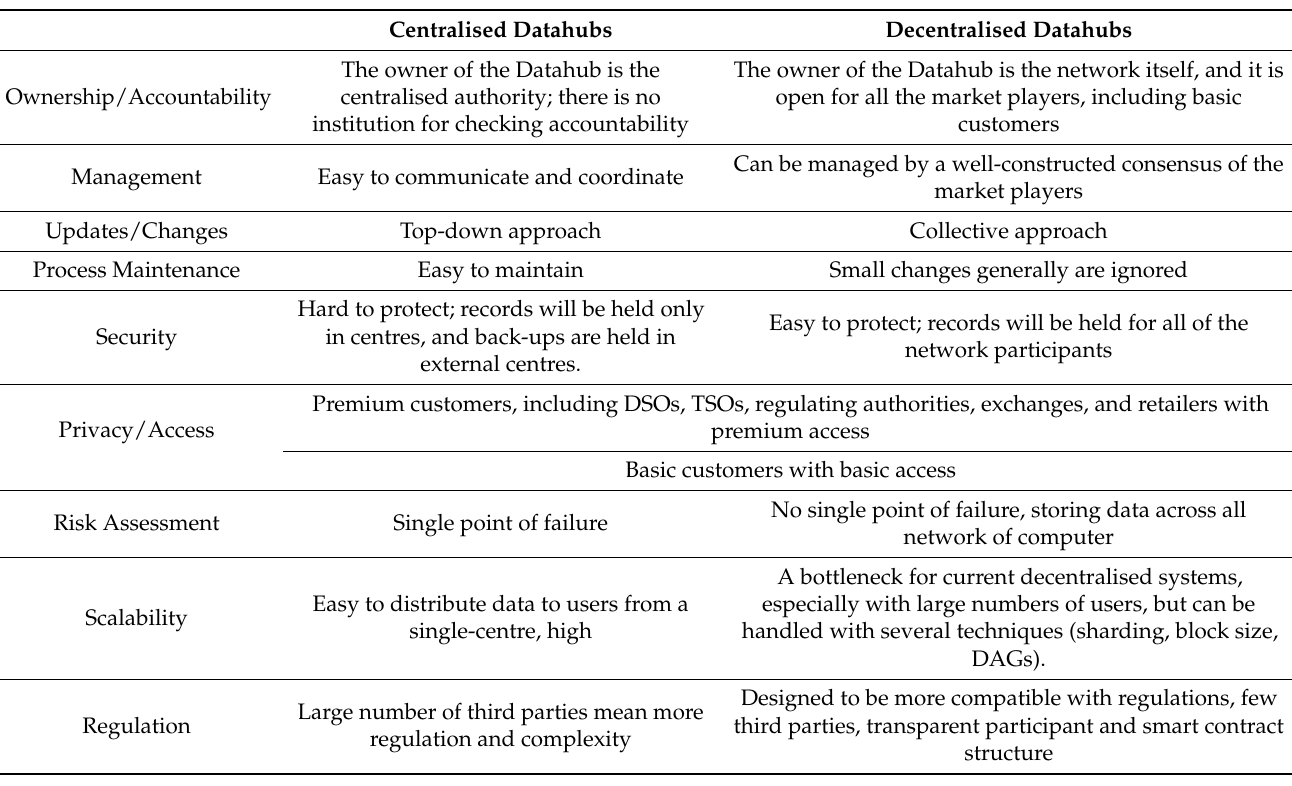
Figure 2. Centralised Energy Datahub Ecosystem Participants [3]. Table 2. Centralised vs. Decentralized Datahub Comparison. Centralised Datahubs Decentralised